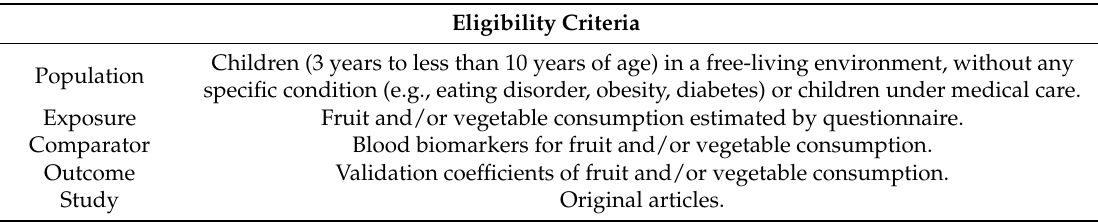
Table 1. Eligibility criteria included in the systematic